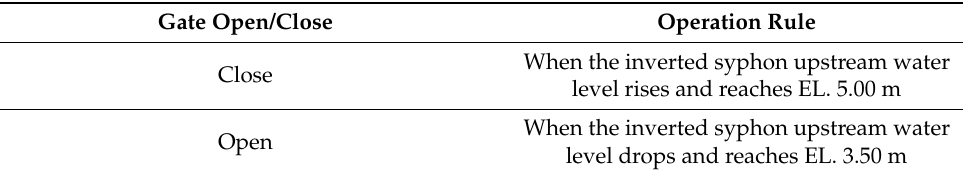
Table 11. Inverted Syphon Gate Operation